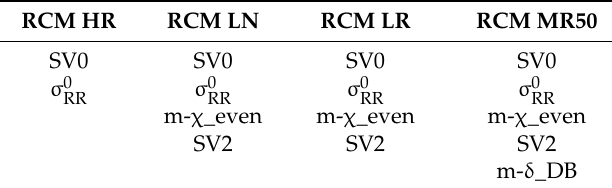
Table 5. Extracted feature vector for each RCM SAR mode. HR = High Resolution, LN = Low Noise, LR = Low Resolution, and MR50 = Medium Resolution 50